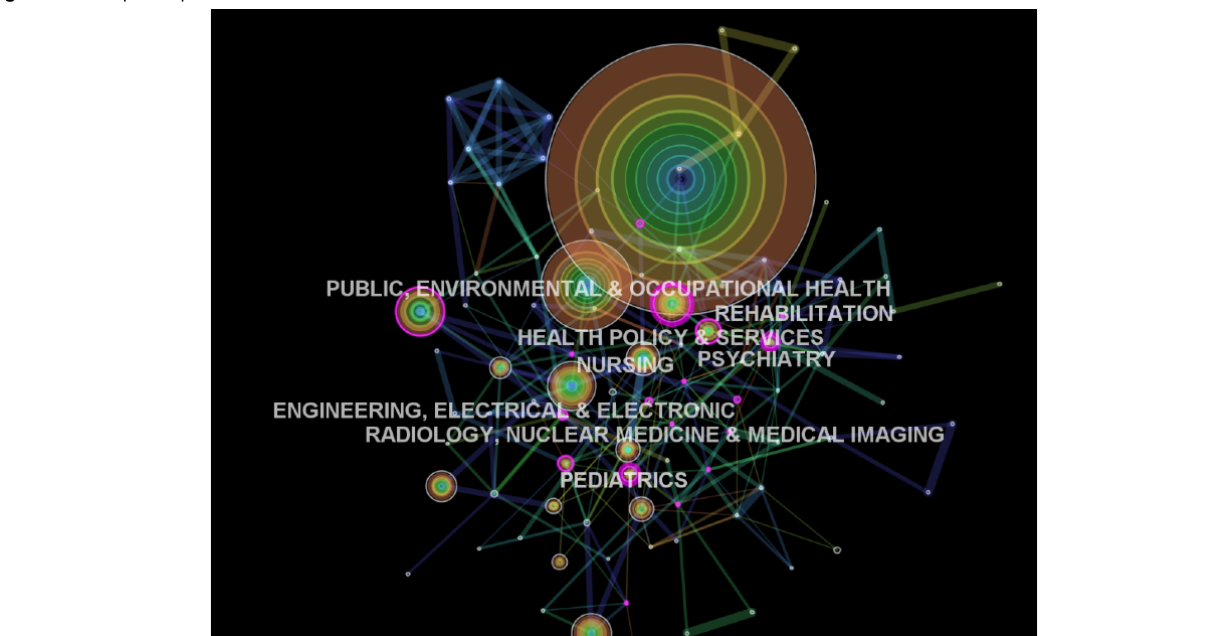
Figure 4. Discipline-specific trends in telemedicine research.